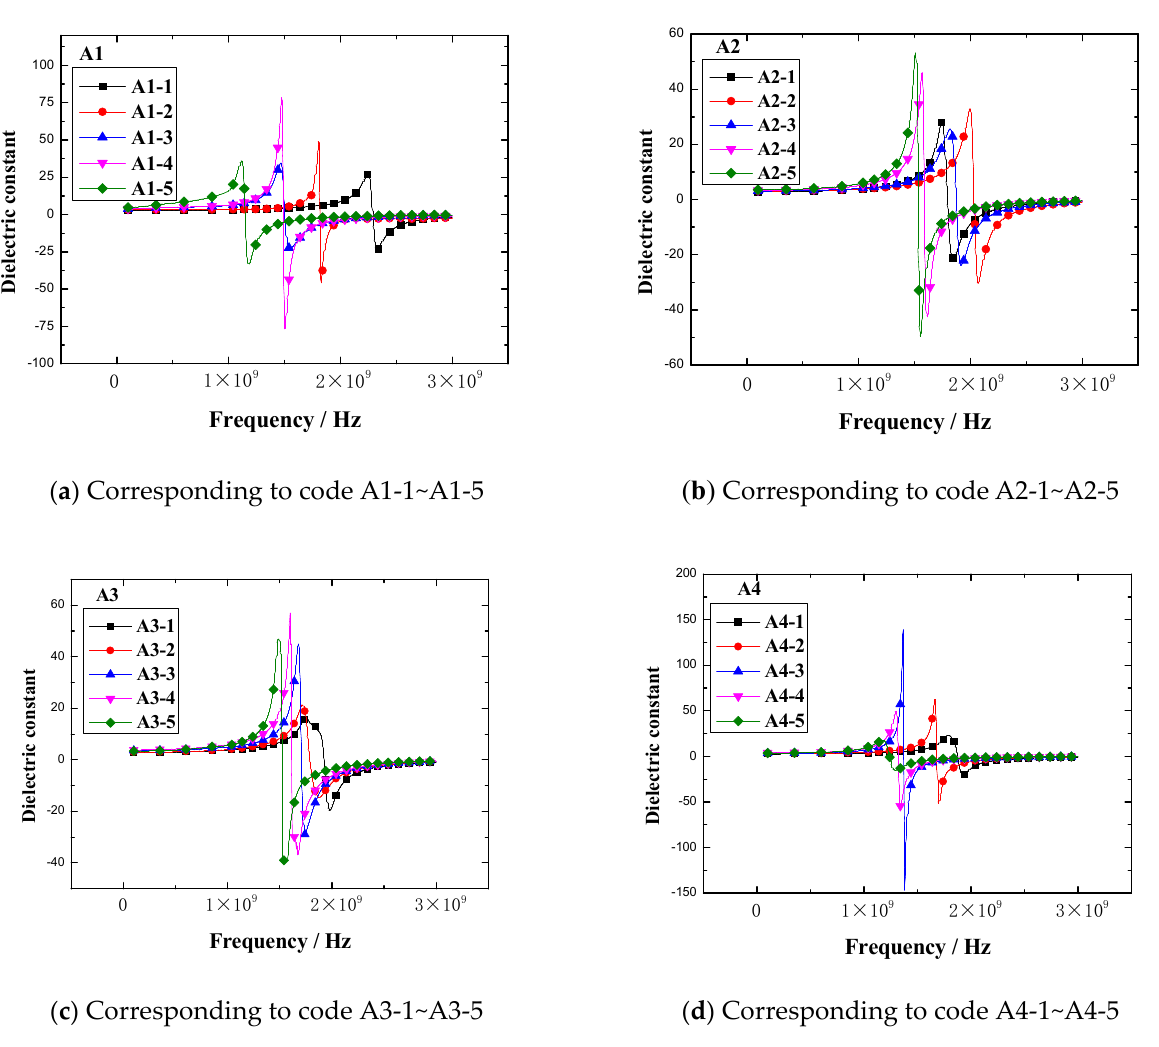
Figure 9. The dielectric constant vs. frequency plots of the rubber samples.